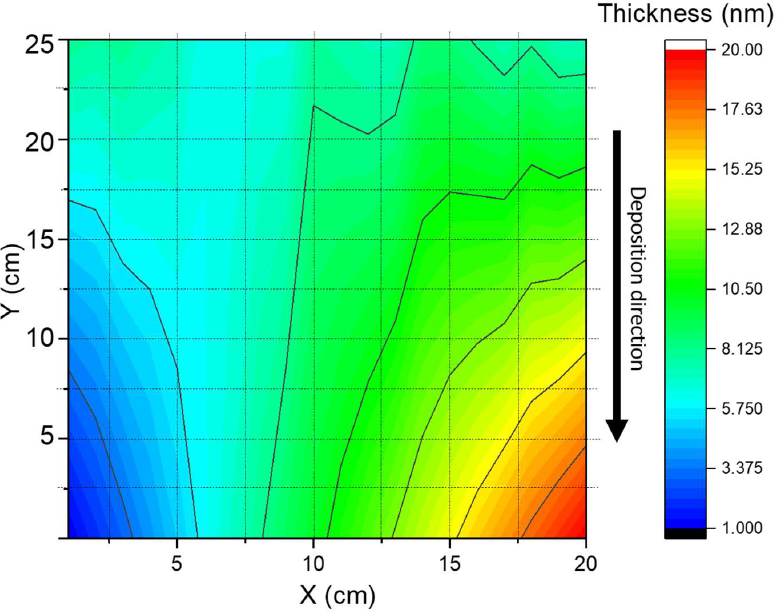
Figure 2. Ellipsometry statistic of PET/ITO/PTAA; 5 mg/mL concentration used. Average thickness